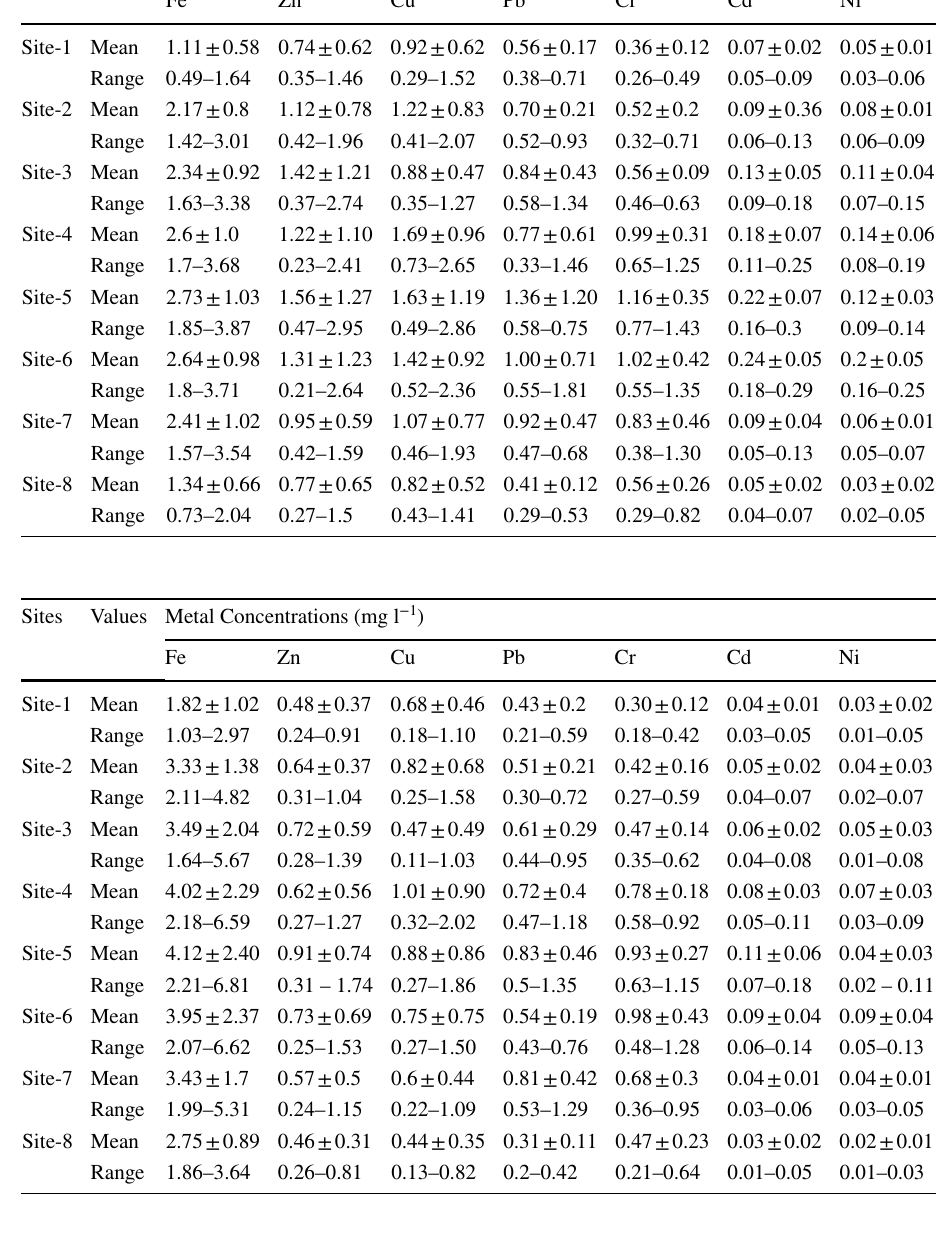
Table 6 Mean concentration of heavy metals during dry season